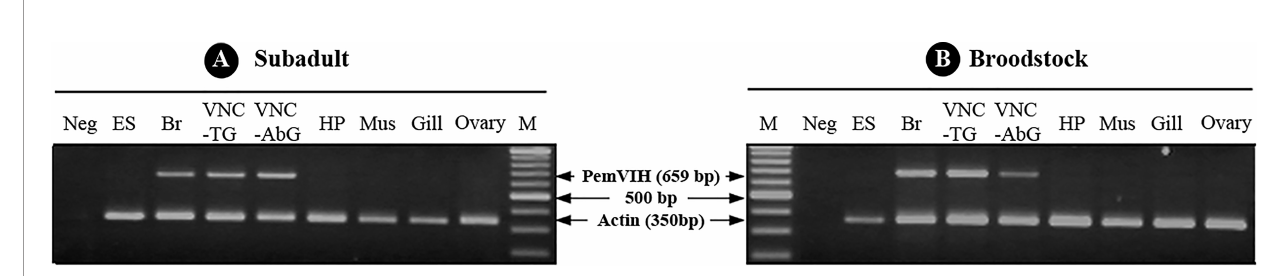
FIGURE 4 | PemVIH expression pro fi le. RT-PCR of PemVIH in (A) subadult and (B) broodstock female P. monodon . The PemVIH and actin amplicons are 659 bp and 350 bp, respectively. PemVIH was speci fi cally expressed in the nervous tissues including Br, VNC-TG and VNC-AbG of subadult and broodstock, but not the ES. M, DNA ladder; Neg, negative control.